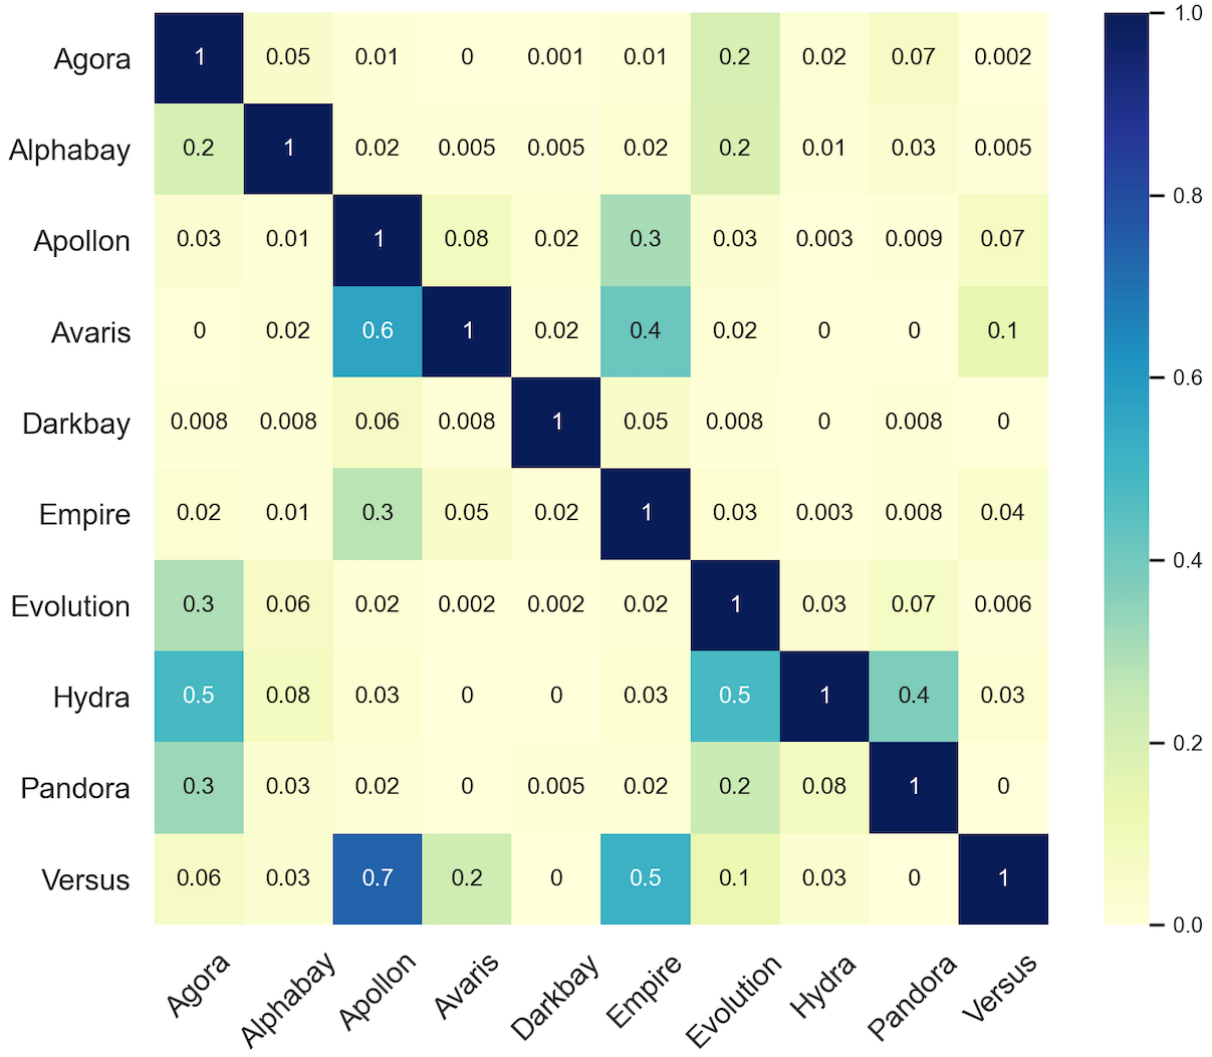
Figure 6. Co-occurrence of the same opioid suppliers across different anonymous